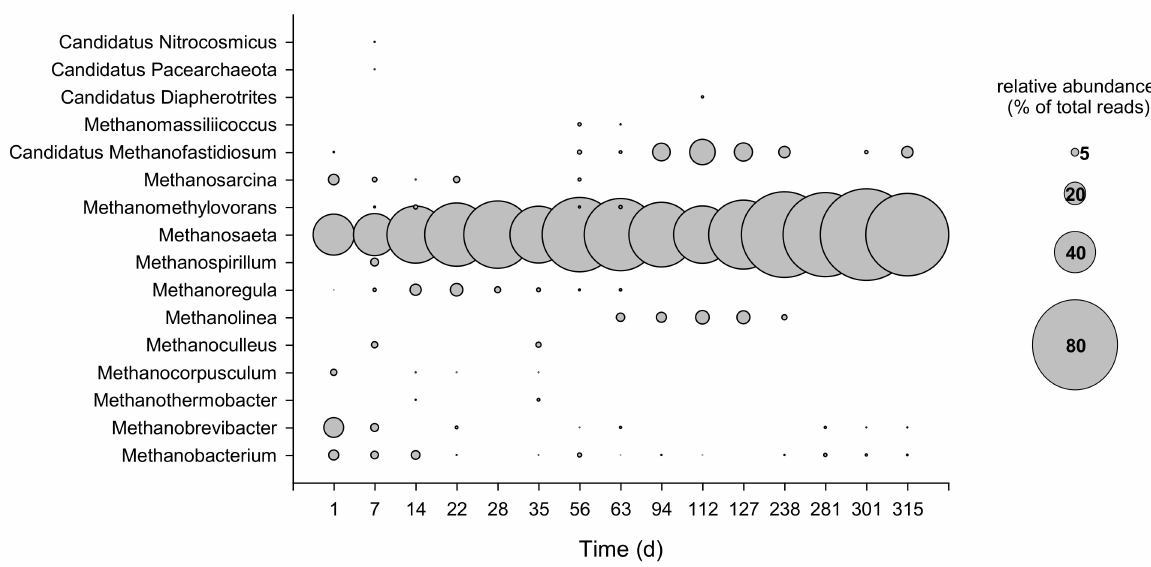
Figure 6. Bubble plot depicting the relative abundance (as % of total reads) of the main archaeal genera ( ≥ 1% relative abundance in at least one sample). The bubble size shows the relative